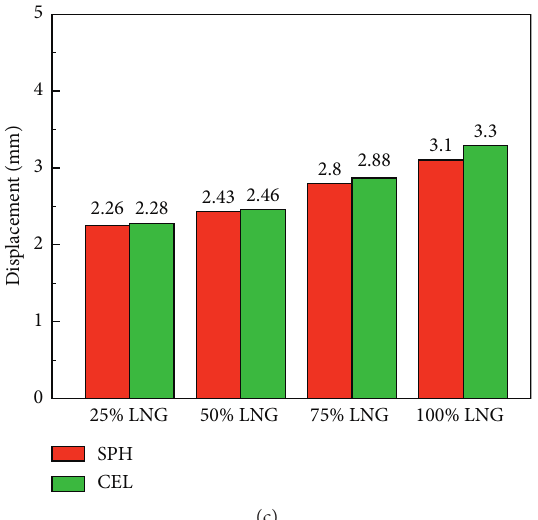
Figure 17: Comparison of the maximum tip displacement of the outer wall under different liquid volume between the two algorithms. (a) El Centro, (b) Northridge, and (c)